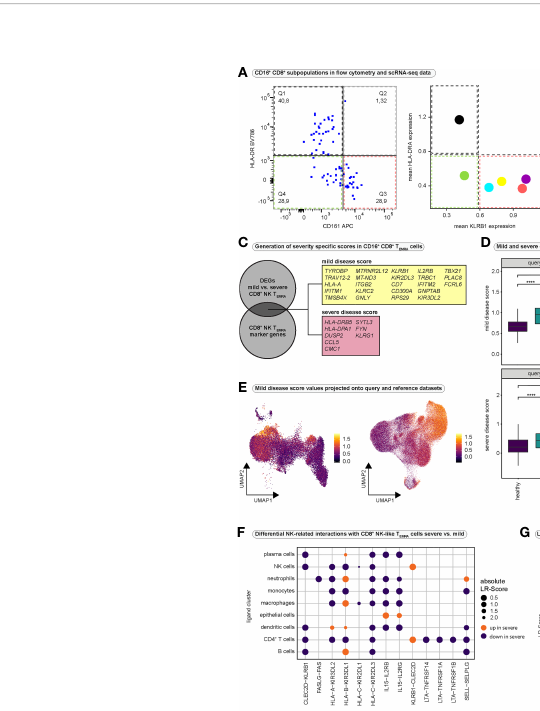
FIGURE 6 Validation of CD16 + CD8 + T EMRA cells and cell-cell interaction analysis. (A) Validation of the existence of CD16 + CD8 + T EMRA subsets, identi fi ed in scRNA-seq data. The expression of HLA-DR (highly expressed in CD16 + CD8 + T EMRA -6 cells) and CD161 (highly expressed by CD16 + CD8 + subsets 2 to 5) was investigated in single, live CD16 + CD8 + T cells in a fl ow cytometry dataset (left panel). As a comparison, the mean expression of the corresponding genes ( HLA-DRA as an example of an HLA-DR gene, as well as KLRB1 encoding CD161) in the CD16 + CD8 + subpopulations is shown (right panel). (B) UMAP embedding of the CD8 + T cell reference dataset ( n = 114,209). Cells that mapped together with the CD8 + NK-like T EMRA cells from our query dataset after integration are highlighted in green. (C) Schematic illustrating the generation of mild and severe disease scores. Differential gene expression analysis was performed between mild and severe disease groups for all CD16 + CD8 + T EMRA cells. Differentially expressed genes that overlapped with highly signi fi cant marker genes of CD16 + CD8 + T EMRA cells (CD8 + NK-like T EMRA cells) were identi fi ed. Genes that were differentially upregulated in cells from mild disease (average log2-fold change > 0.25) were combined into the mild disease score, whereas genes that were differentially downregulated in cells from mild disease (average log2-fold change < 0.25) were combined into the severe disease score. (D) Comparison of mild (top) and severe (bottom) disease scores in NK-like CD8 + T cell subsets between conditions in our query dataset (left), between conditions in the PBMC-derived reference dataset (middle) and between outcome groups in the PBMC-derived reference dataset (right). Kruskal-Wallis test was used for signi fi cance testing. (query mild disease score: Kruskal- Wallis test: H (2) = 462.6, p < 0.0001; healthy vs. mild: p < 0.0001; healthy vs. severe: p < 0.0001, mild vs. severe: p < 0.0001; query severe disease score: Kruskal-Wallis test: H (2) = 330.5, p < 0.0001; healthy vs. mild: p < 0.0001; healthy vs. severe: p < 0.0001, mild vs. severe: p